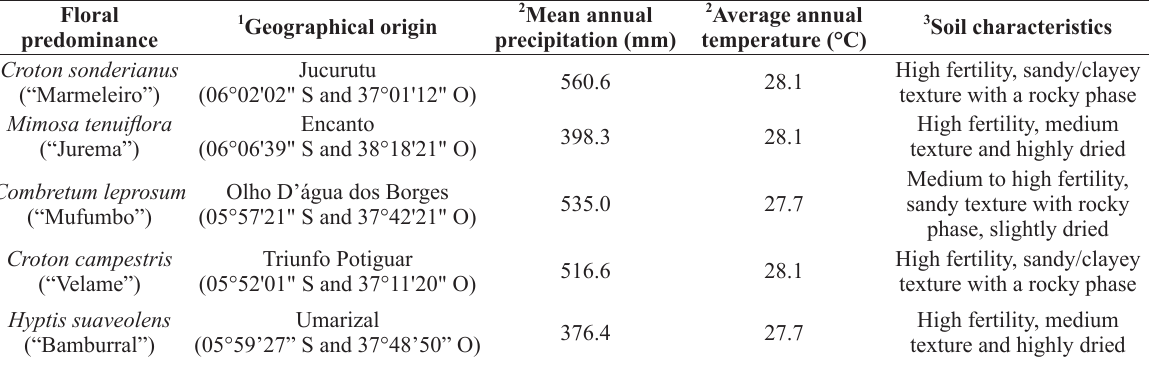
Floral and geographical information for honey